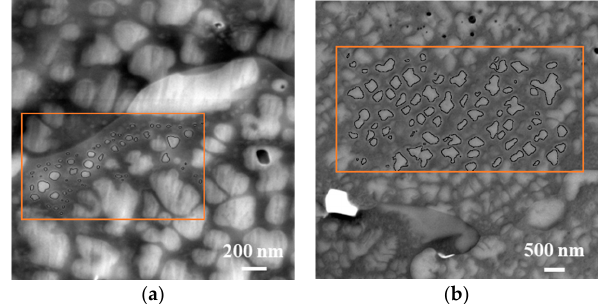
Figure 1. Examples of backscattered scanning electron microscopy (SEM) images used for precipitate size analysis: ( a ) for tertiary gamma prime, the magnification was ≈ ×170,000 and ( b ) for secondary gamma prime, the magnification used was ≈ ×21,000.